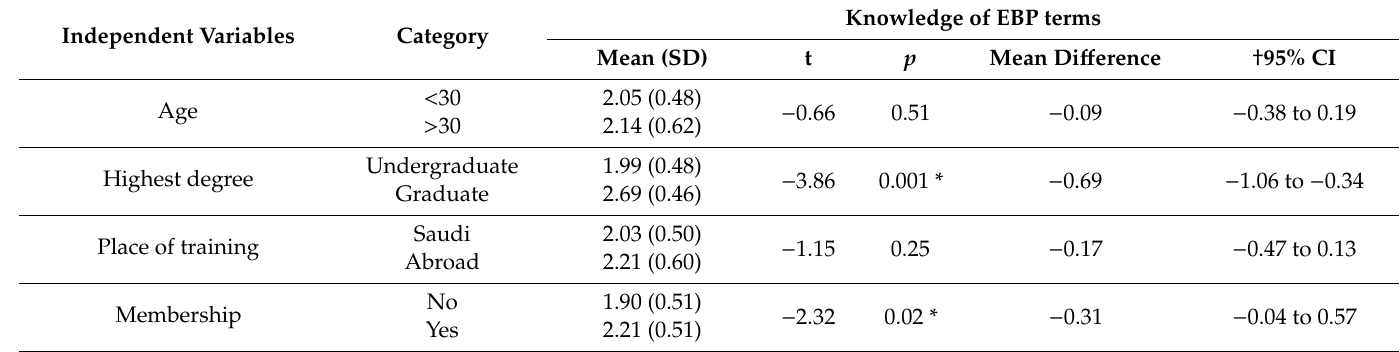
Table 6. Comparison of demographic characteristics and knowledge of evidence-based practice (EBP) terms (confidence intervals, publication bias, relative risk, and systematic